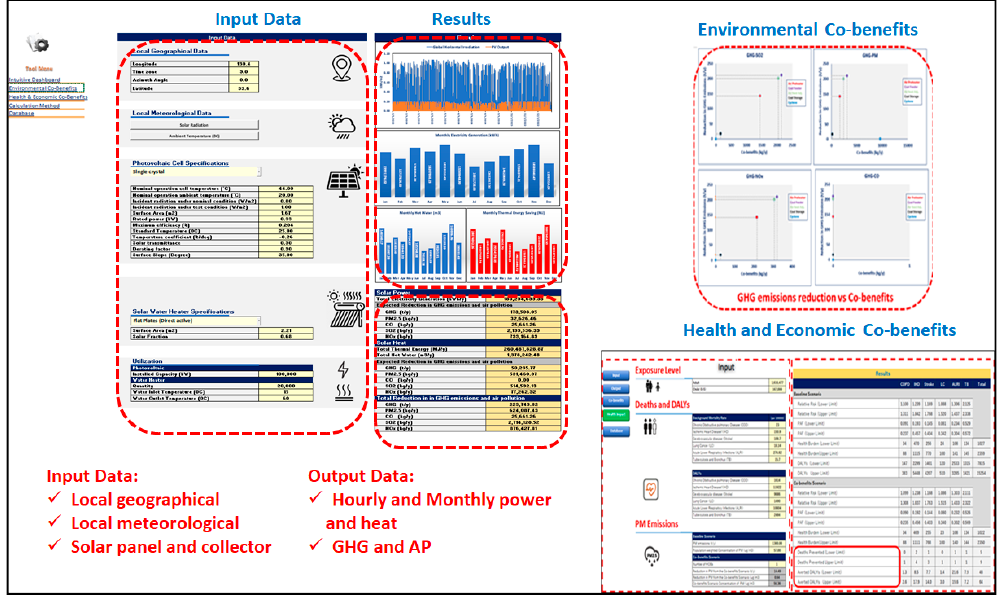
Figure 6. Overall view of the co-benefits assessment spreadsheet tool (Created by the authors).